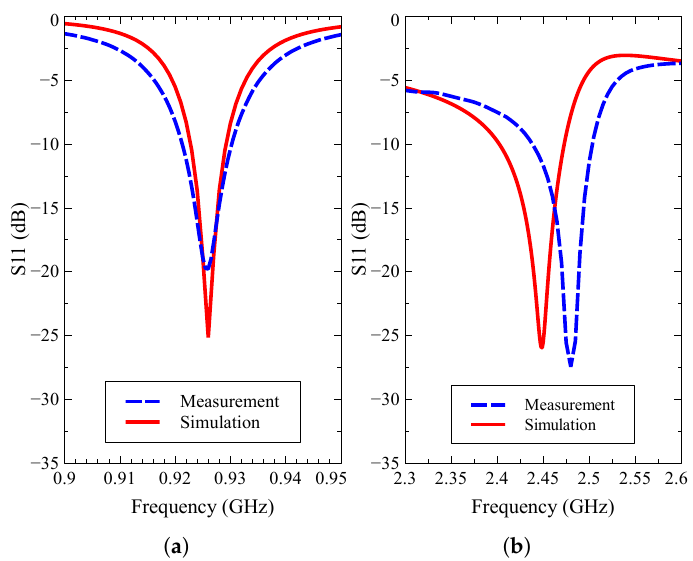
Figure 11. Simulated and measured reflection coefficient of the antenna at ( a ) low-frequency band and ( b ) high-frequency band.